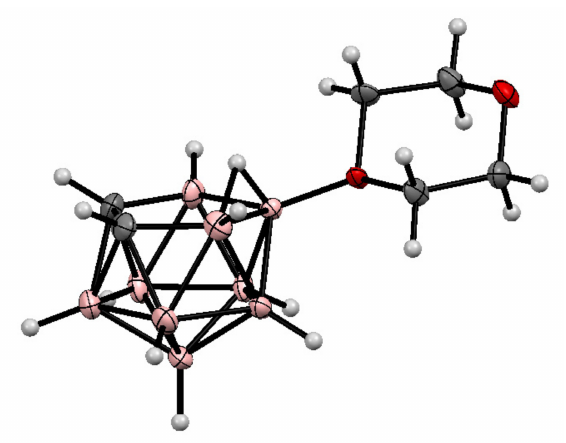
Figure 1. The molecular structure of 10-O(CH 2 CH 2 ) 2 O-7,8-C 2 B 9 H 11 . It should be noted that, in addition to cyclic oxonium derivatives of nido -carborane, some acyclic oxonium derivatives such as the dimethyloxonium 9-Me 2 O-7,8-C 2 B 9 H 11 and 10-Me 2 O-7,8-C 2 B 9 H 11 [72] and the diethyloxonium 9-Et 2 O-7,8-C 2 B 9 H 11 [73] and 10- Et 2 O-7,8-C 2 B 9 H 11 [70,73,74] derivatives are known as well. The molecular structure of the 10-diethyloxonium derivative of nido -carborane was determined by single crystal X-ray diffraction [73] (Figure 2). The formation of the 1,2-dimethoxyethane derivatives 9-MeOCH 2 CH 2 (Me)O-7,8-C 2 B 9 H 11 and 10-MeOCH 2 CH 2 (Me)O-7,8-C 2 B 9 H 11 was also re- ported, however they have low stability and easily lose the methyl group, giving the corresponding alkoxy derivatives